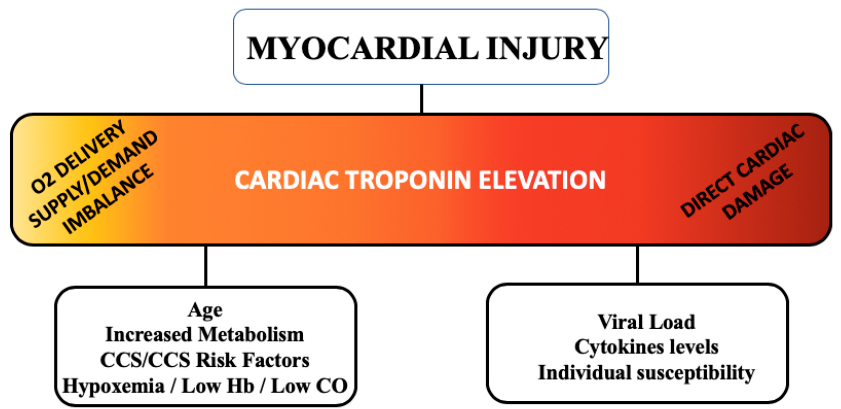
Figure 3. culprit mechanisms behind the development of myocardial injury in